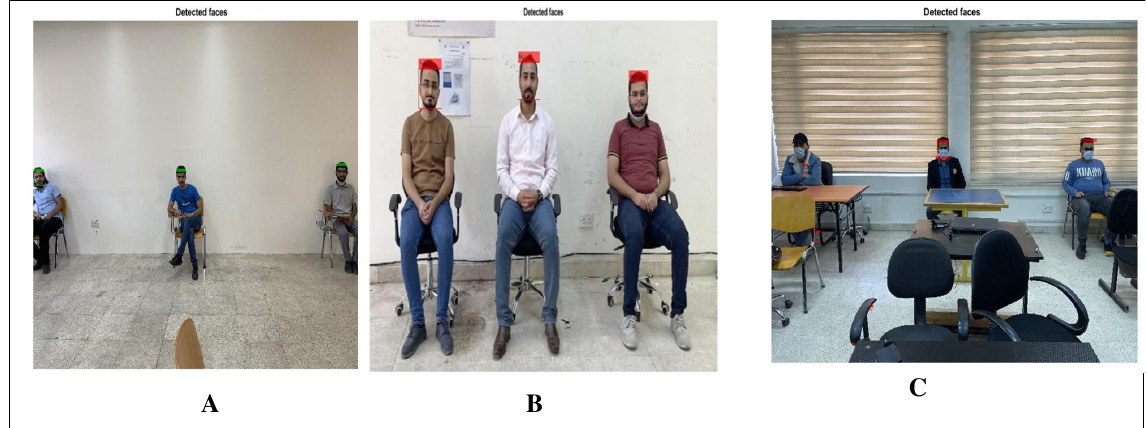
Fig. 12 . Monitor Social Distancing (A) Ed > Du (B) Ed < Du (C) Ed < Du with wearing a